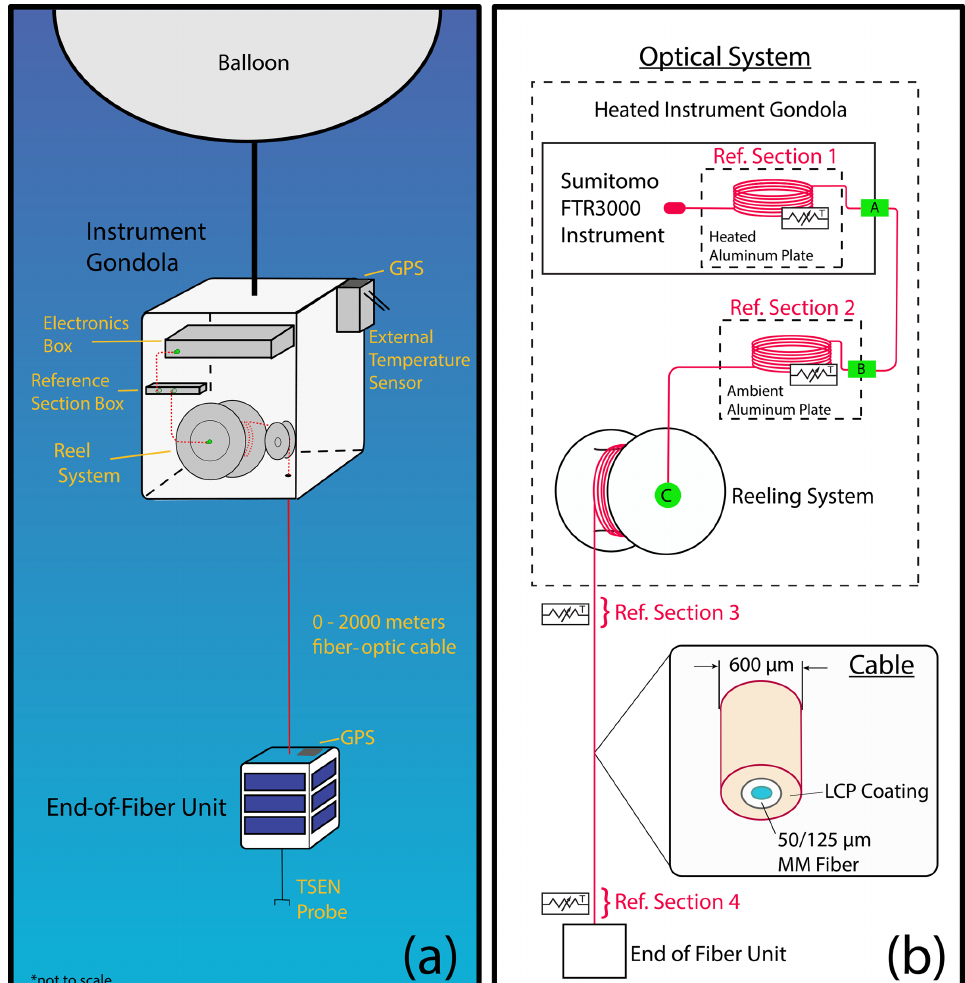
Figure 1. Illustration of the components of the FLOATS instrument (a) and optical system (b) . Fiber-optic connections are depicted in panel (b) with green icons. The thermistor electrical symbols depicted in panel (b) are used to represent the location of a reference temperature